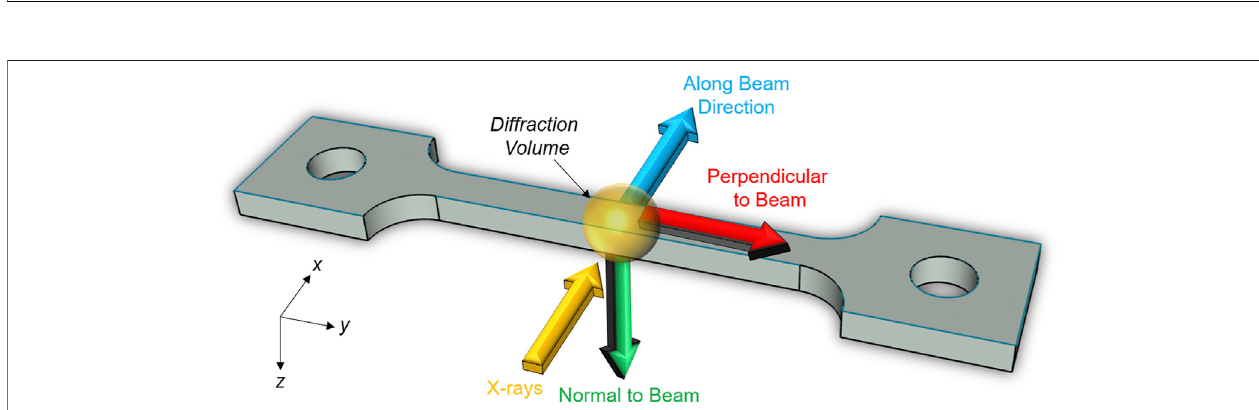
FIGURE 2 | Schematic illustration showing the direction of the x-rays and the diffraction tensors along the beam direction (x), perpendicular to the beam (y), and normal to the beam (z). These de fi nitions apply to diffraction and DIC analyses.